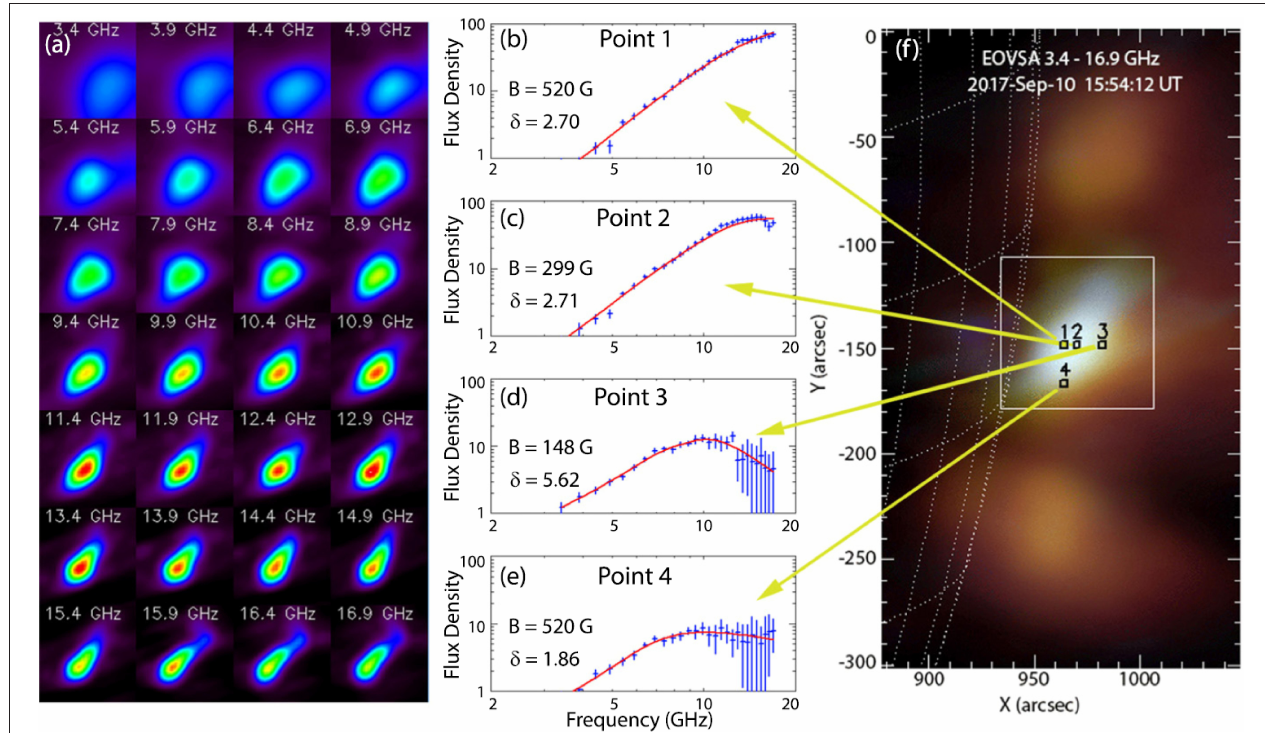
FIGURE 15 | (a) Images of the microwave emission from a partially occulted limb flare obtained at 28 frequencies with EOVSA. The field of view of the images corresponds to the white box of panel (f) . (b–e) Flux density spectra in those pixels of the images of panel (a) that correspond to points 1–4 of panel (f) , together with model spectral fits (red lines). (f) True-color display of the EOVSA dataset after combining images at the 28 frequencies that are marked in panel (a) . From Gary et al. (2018). © AAS. Reproduced with